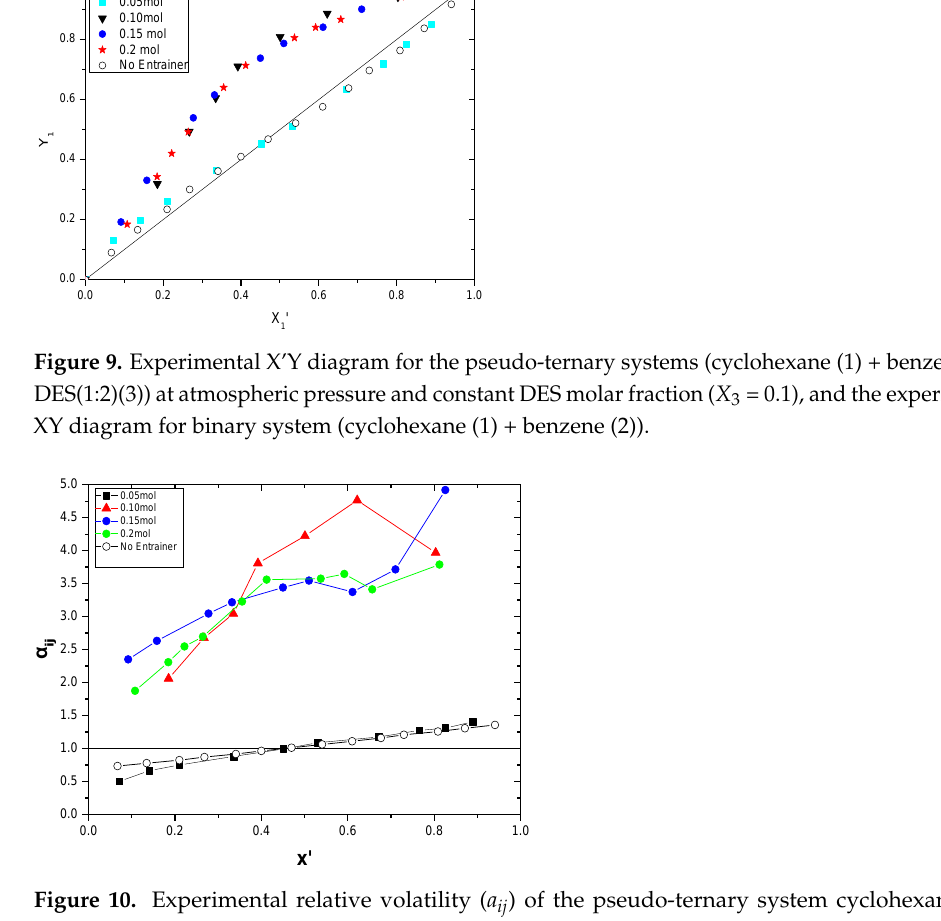
Figure 10. Experimental relative volatility ( a ij ) of the pseudo-ternary system cyclohexane (1) + benzene (2) + DES(1:2) (3) and binary system cyclohexane (1) + benzene (2).